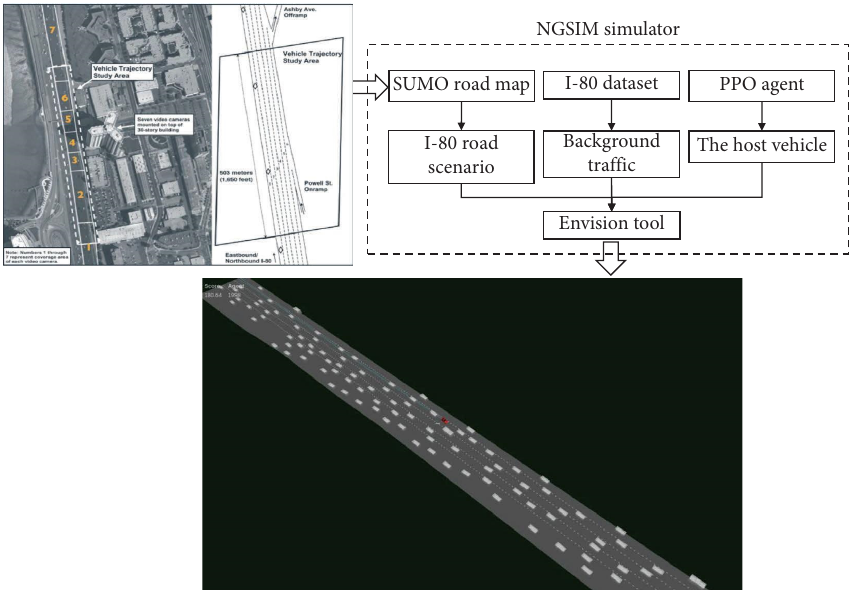
Figure 1: Te framework of the NGSIM simulator.